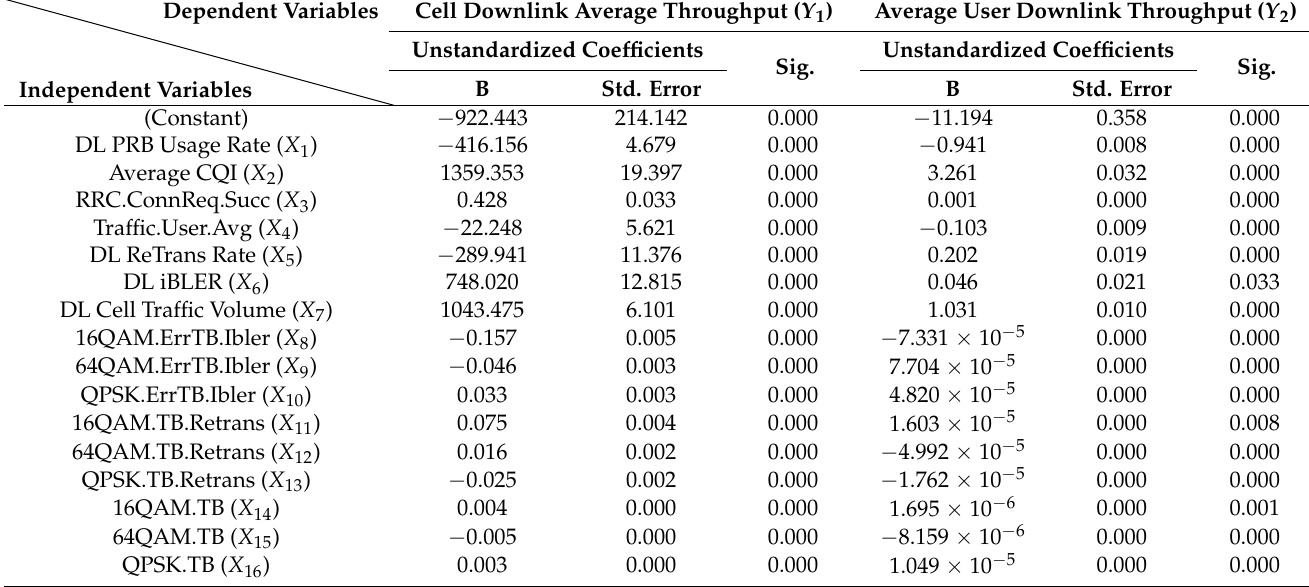
Table 6. Basic results of the regression